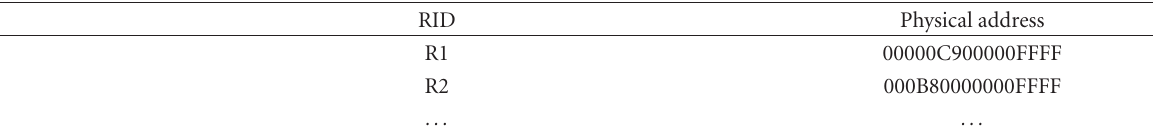
Table 3: Mapping table example.